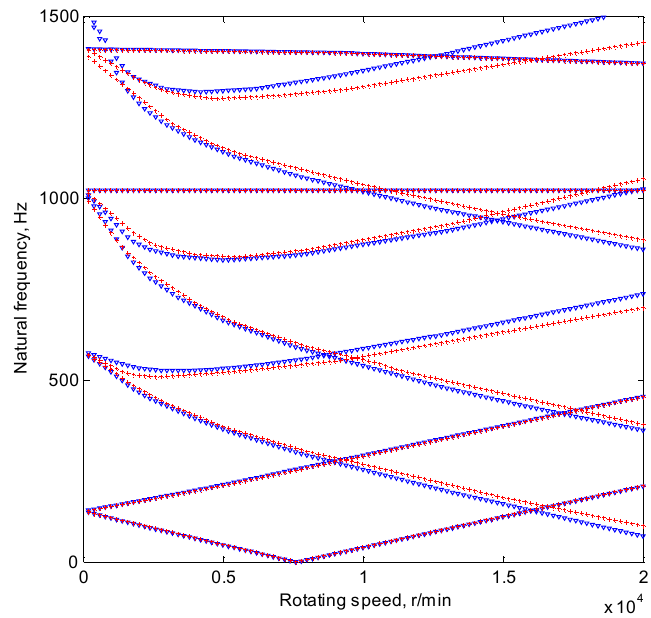
β of the fixed case is 0.2. k